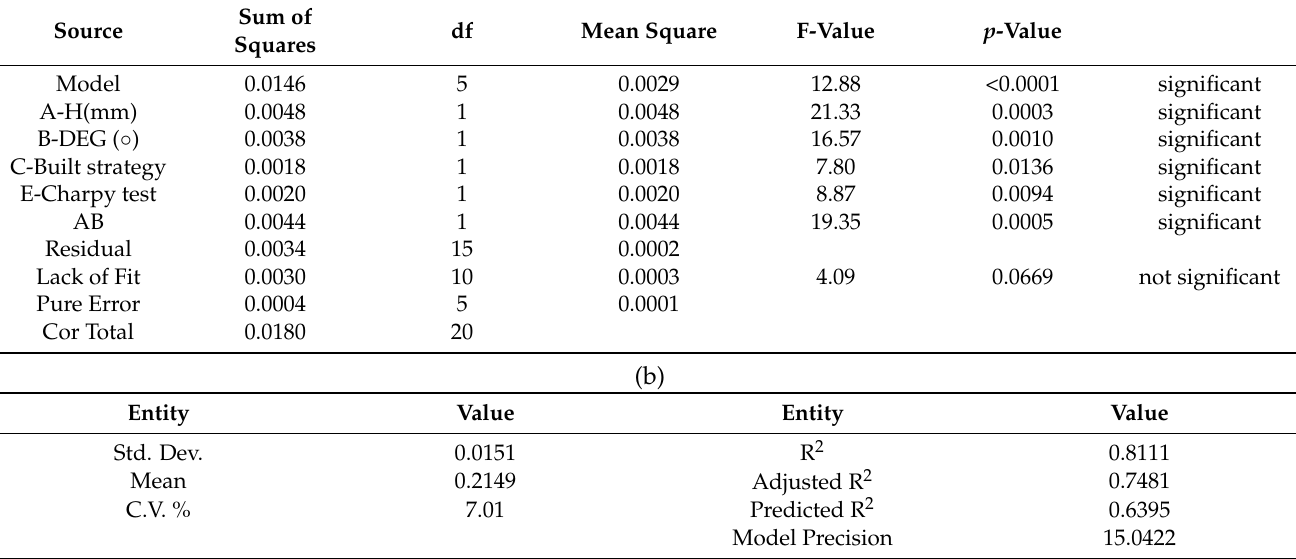
Table 4. (a) ANOVA output from for the impact strength analysis using a reduced 2FI model with a transformed response using the inverse square root transform. (b) Regression fitting parameters for the impact strength analysis using a reduced 2FI model with a transformed response using the inverse square root transform.